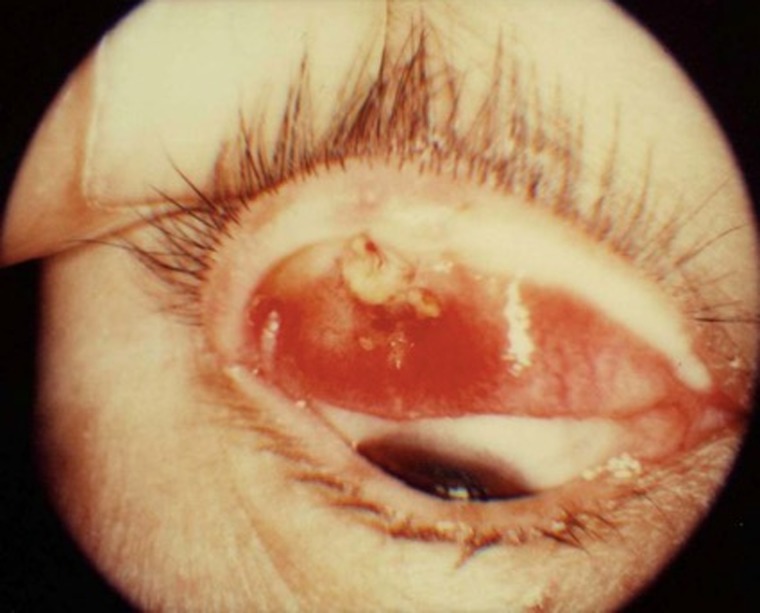
Typical finding of sebaceous carcinoma of the eyelid.